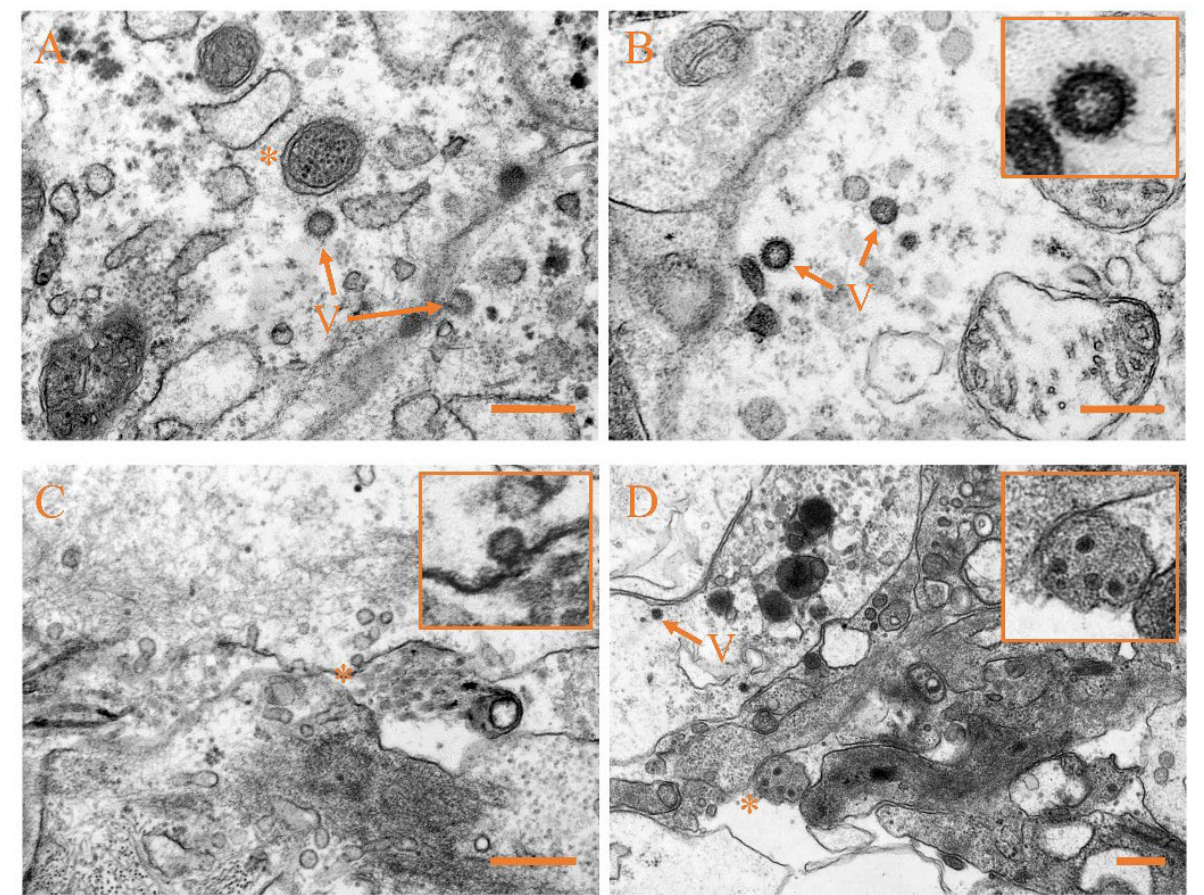
Figure 5. Transmission electron micrographs of liver, kidney, ovary, and spleen from CSBV Bces- Po19-infected Japanese flounder ( Paralichthys olivaceus ). ( A ) Liver, with arrows indicating the ma- ture virions; asterisk indicates the mitochondrion with virion-like, granular osmiophilic substances. ( B ) Kidney, with arrows indicating the mature virions. ( C ) Ovary, with asterisk indicating viral bud- ding from the infected cell membrane. ( D ) Spleen, with arrow indicating the mature virion; asterisk indicates the mitochondrion with virion-like, granular osmiophilic substances. Scale bars: 400 nm.